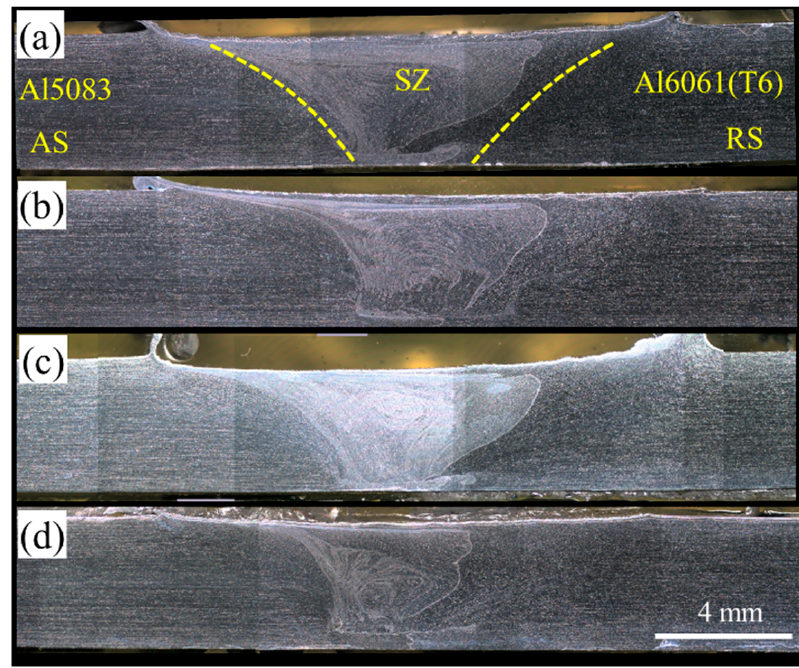
Figure 4. Macro photos of PWHTed Al5083-Al6061(T6) Samples; ( a ) A-1(PWHT), ( b ) C-1(PWHT), ( c ) D-1(PWHT), and ( d ) C-4(PWHT).